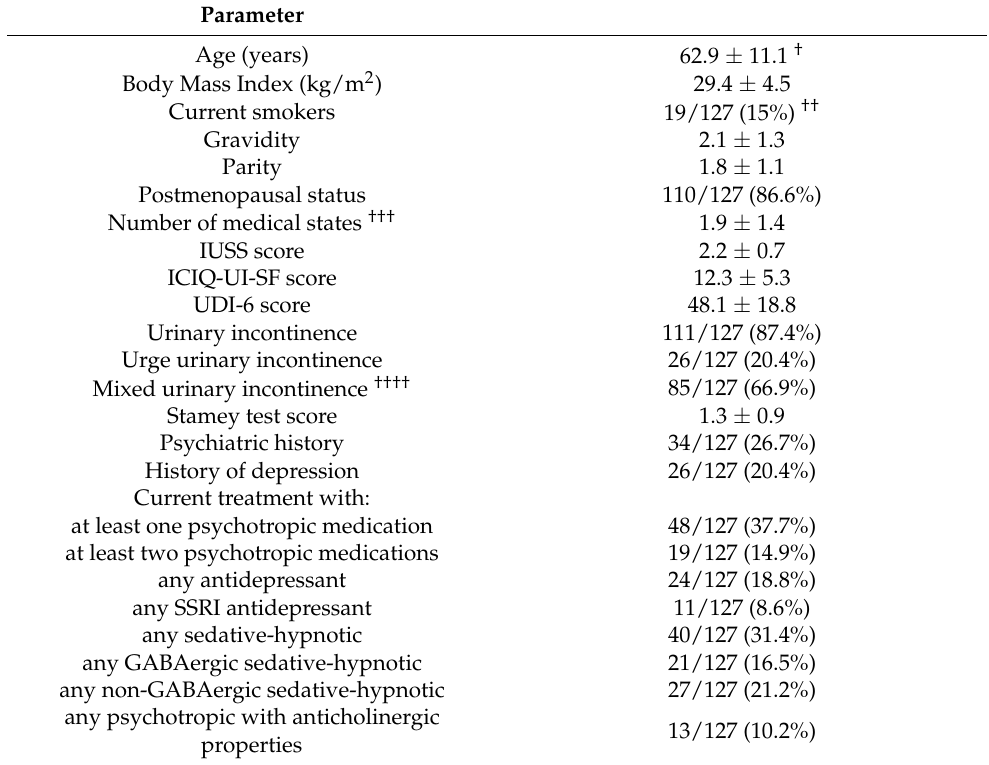
Table 1. Sociodemographic and clinical characteristics of the study group ( n = 127